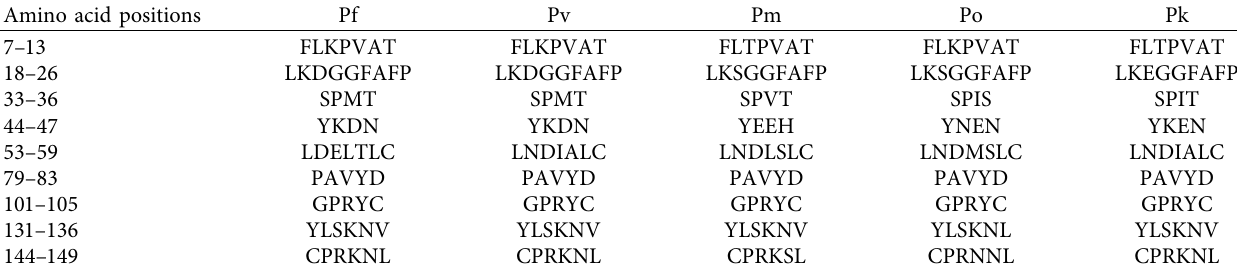
Table 2: Similar conserved amino acid sequences in Domain I of AMA1 in Plasmodium species that infect human. Amino acid positions